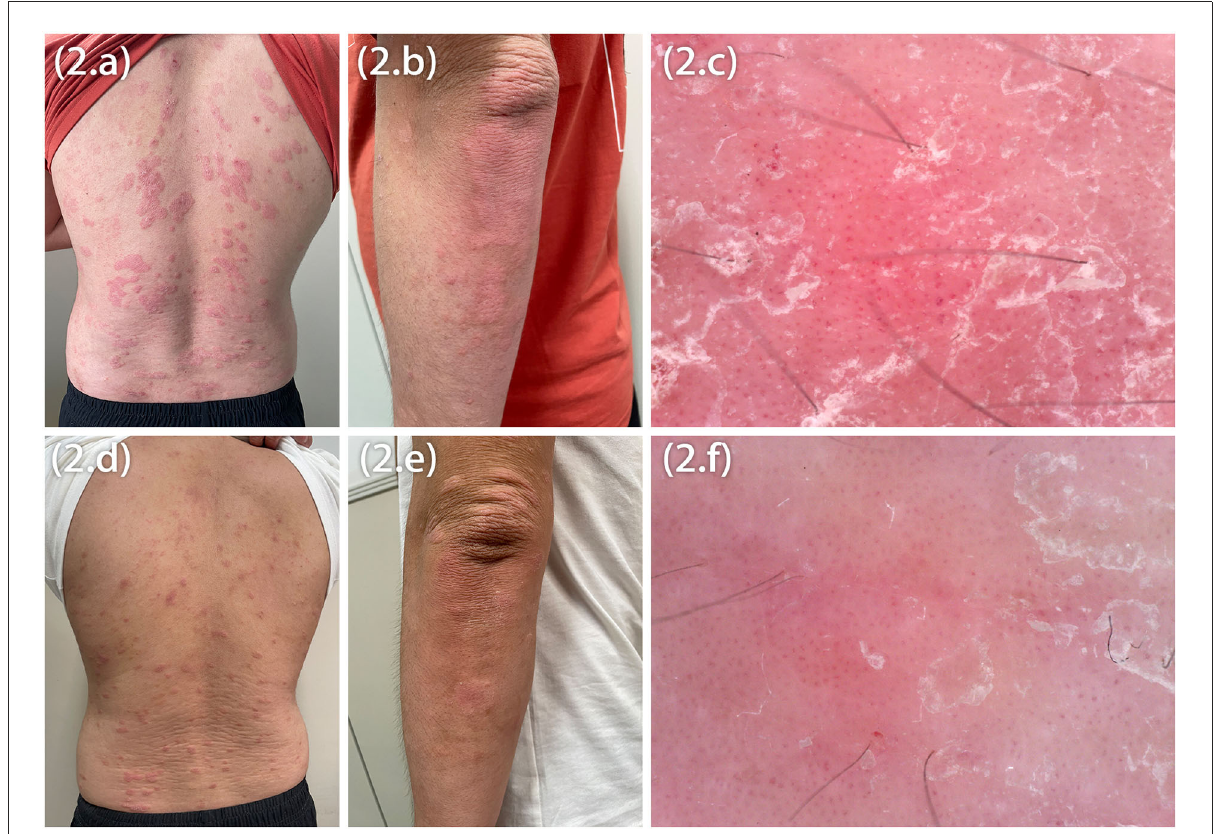
FIGURE2 Psoriasiform eruptions on the trunk and the elbow in both patients (A,B,D,E) , dermoscopic image showing pinpoint bleeding (C,F) .